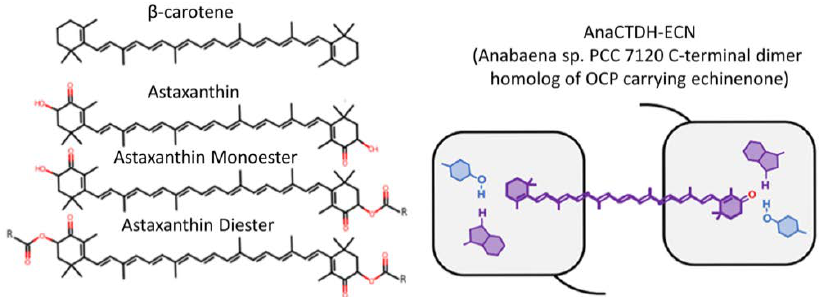
Figure 1. Structure of carotenoids and scheme of carotenoprotein AnaCTDH in holoform (loaded with echinenone) that were involved in the present study.